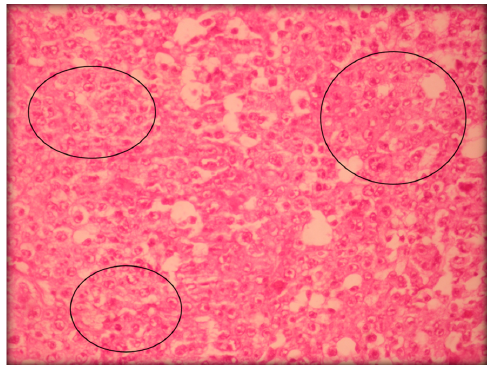
Figure 6. Histopathology of Sarcoma 180 tumor cells was analyzed by light microscopy and stained with hematoxylin-eosin (400×). Circles show the presence of mitosis.